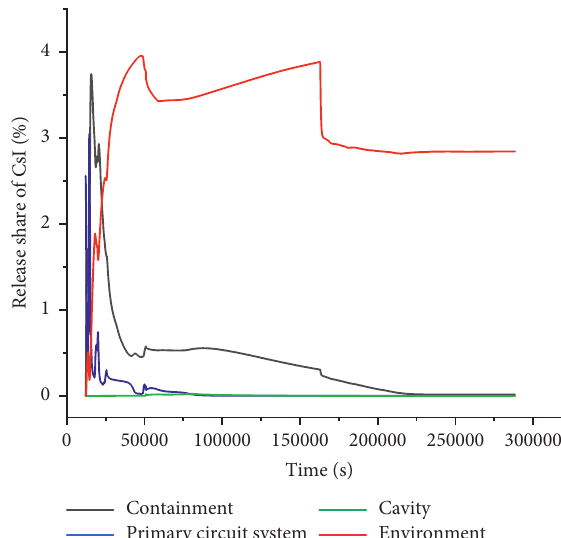
Figure 21: Distribution of CsI in different position.